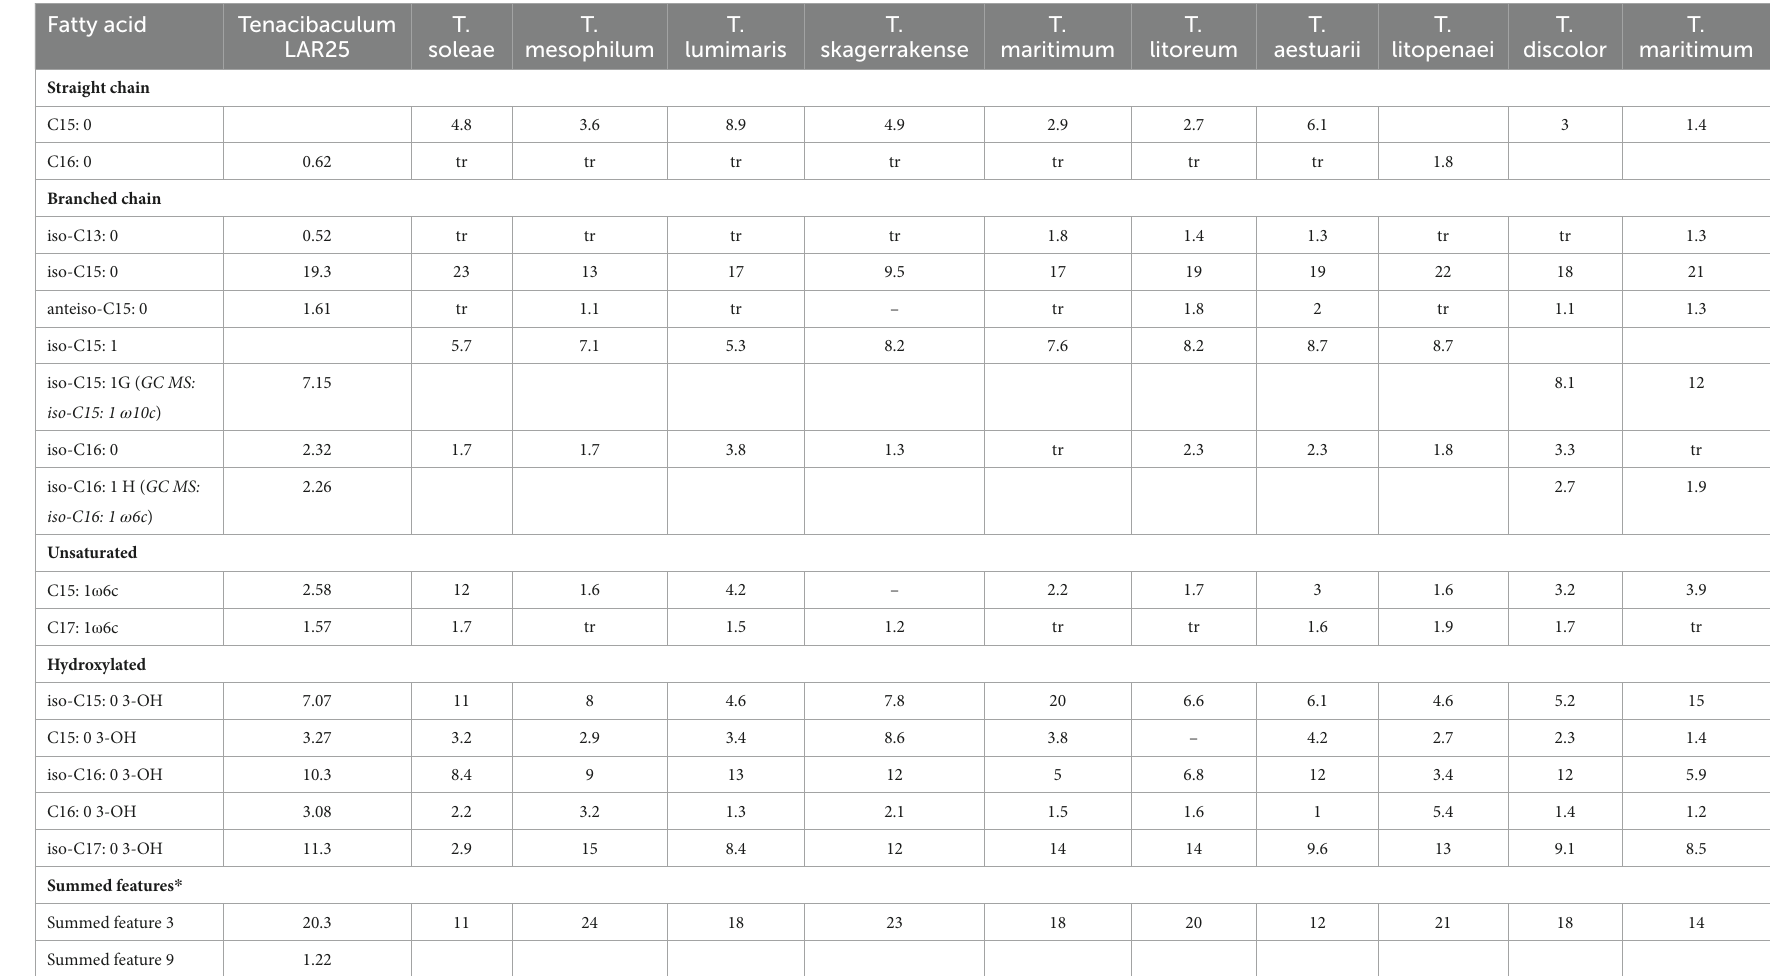
TABLE 2 Cellular fatty acid composition (%) of strain LAR25. Fatty